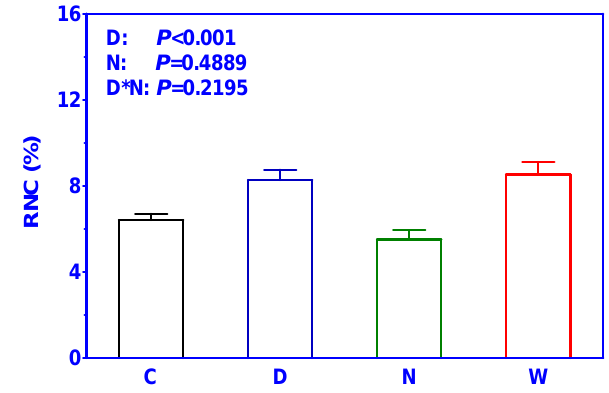
Fig. 4. Effect of different warming regimes (control C, day warming D, night warming N, and continuous warming W) on root nonstruc- tural carbohydrate content (RNC). Data are mean ± SE of six